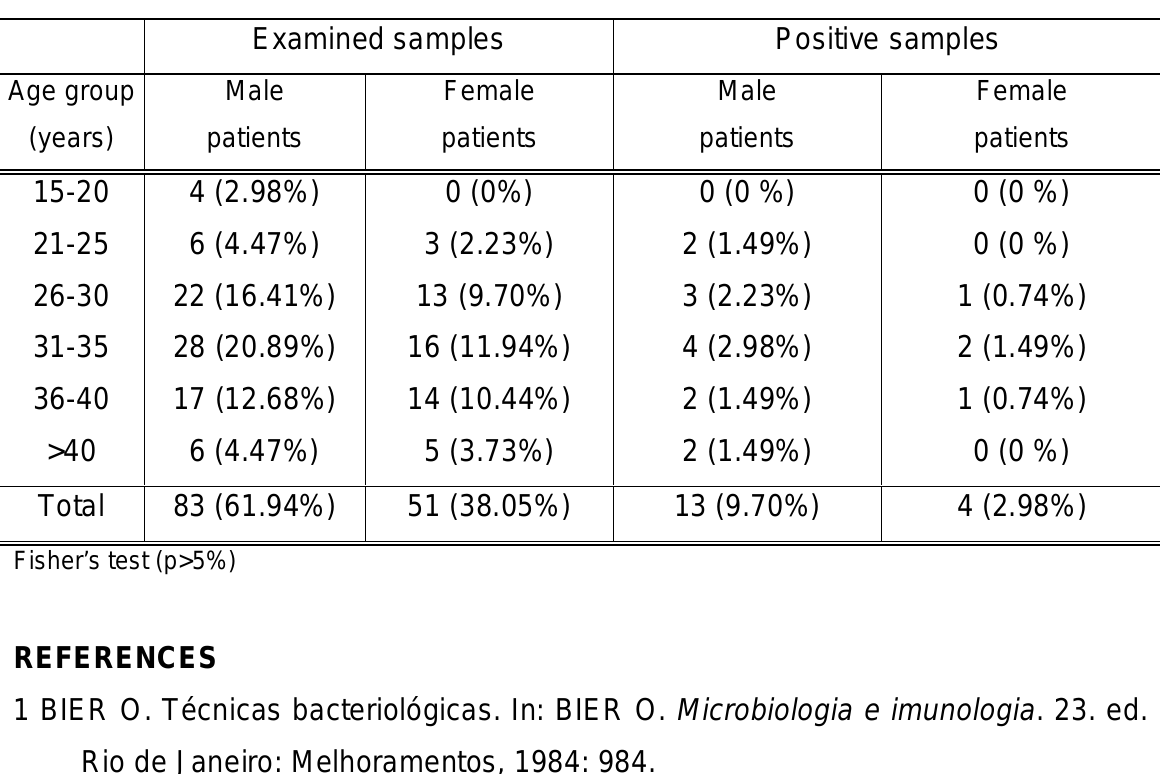
Table 1. Occurrence of Listeria monocytogenes in HIV-infected patients, assisted in the General Hospital of Nova Iguaçu, Rio de Janeiro, Brazil, from July/1999 to